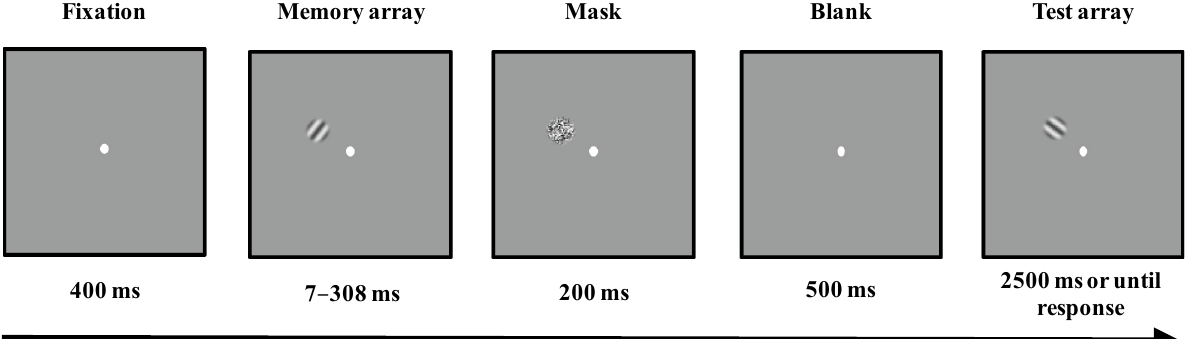
Figure 1. Trial structure of the thresholding procedure in Experiment 1.